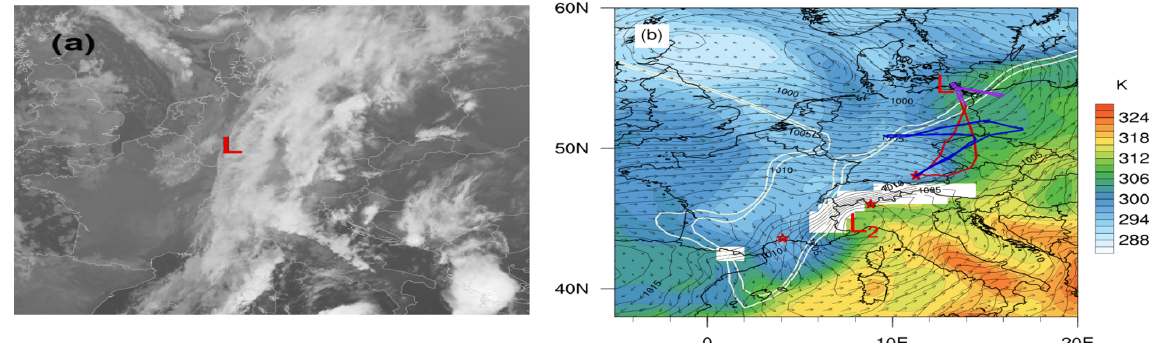
Figure 3. Continuation of the synoptic situation: (a) Meteosat IR image at 06:00UTC on 15 October 2012, (b) same as in Fig. 2a but for 09:00UTC on 15 October. In panel (b) flight IOP2b is shown in red with the violet part from 08:30 to 09:30UTC, flight IOP2c is shown in blue and the red “ L 2 ” marks the position of the secondary